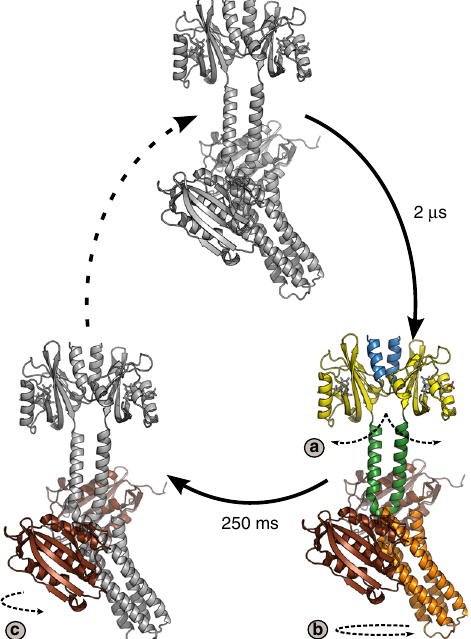
Fig. 6 Structural photoactivation of YF1. Blue light causes sequential structural arrangement in YF1. After 2 μ s the LOV domains splay apart (arrow a), causing supercoiling of the J α helices and the rotation of the entire kinase module (arrow b). After 250ms the kinase domain rearranges internally as the CA domains relocate on the DHp helices (arrow